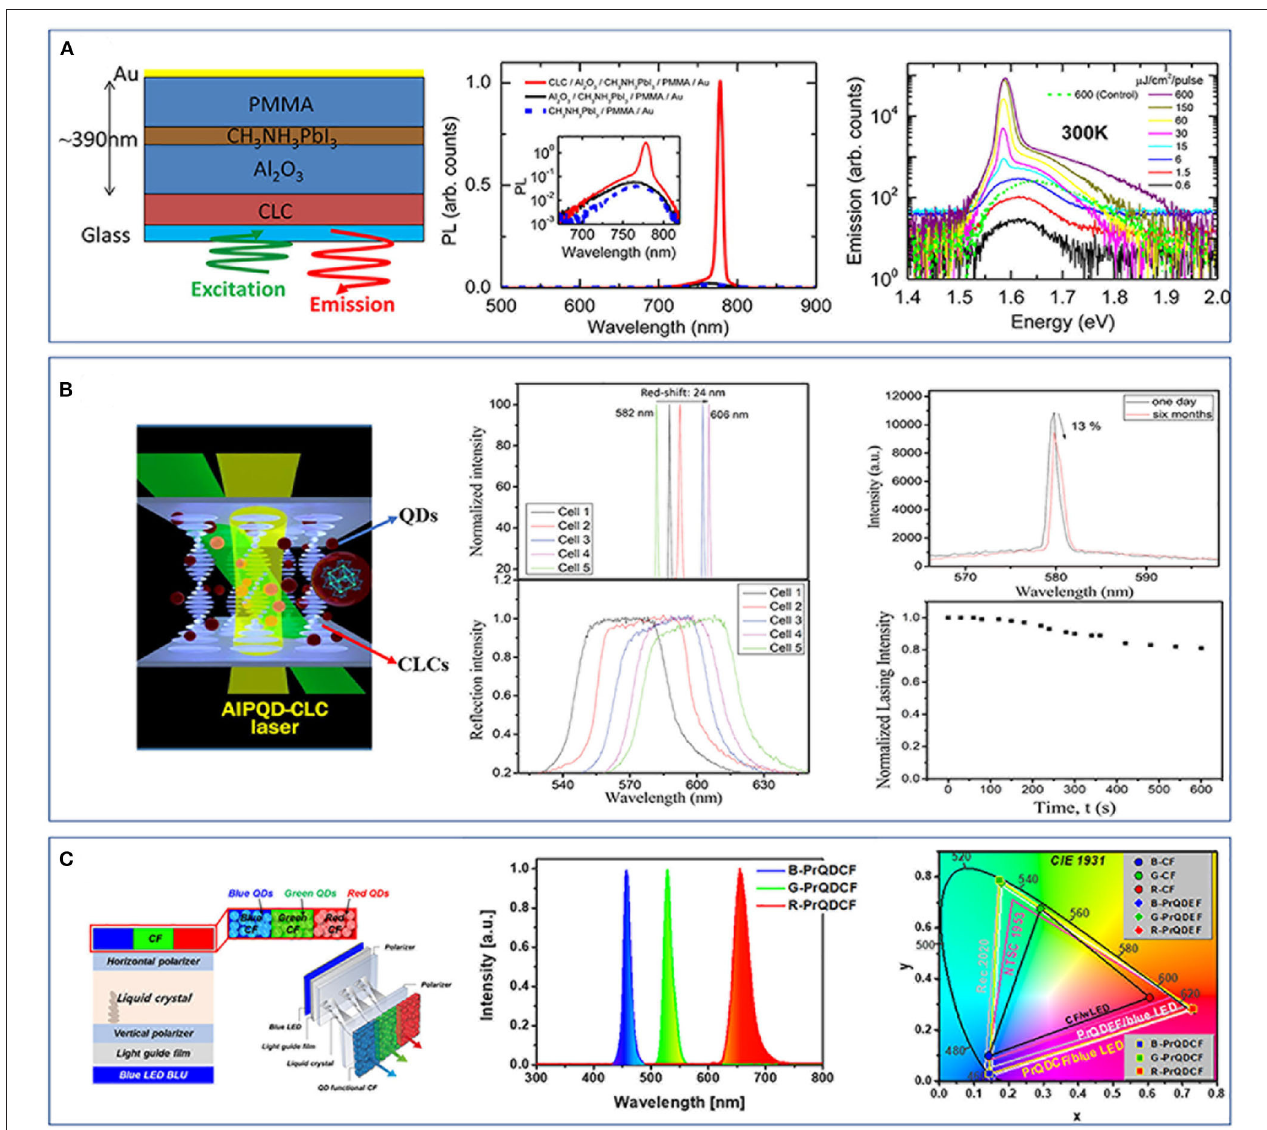
FIGURE 2 | (A) Schematic illustration for a liquid crystal laser structure of a CH 3 NH 3 PbI 3 film, a glass cholesteric liquid crystal (CLC) polymer reflector, an alumina substrate, and a metal backside reflector and its optical performance (Stranks et al., 2015). Reproduced with permission. Copyright 2015, American Chemical Society. (B) A liquid crystal laser doped with CsSnI 2 quantum dots (QDs) and its optical performance (Chen L. J. et al., 2018). Reproduced with permission. Copyright 2018, American Chemical Society. (C) A vertically stacked liquid crystal display (LCD) structure of blue LED, light guide film, vertical polarizer, twisted nematic liquid crystals, horizontal polarizer, and QD functional color filters (CFs) and the optical performance of the CFs and LCD (Ko et al., 2018). Reproduced with permission. Copyright 2018, Springer